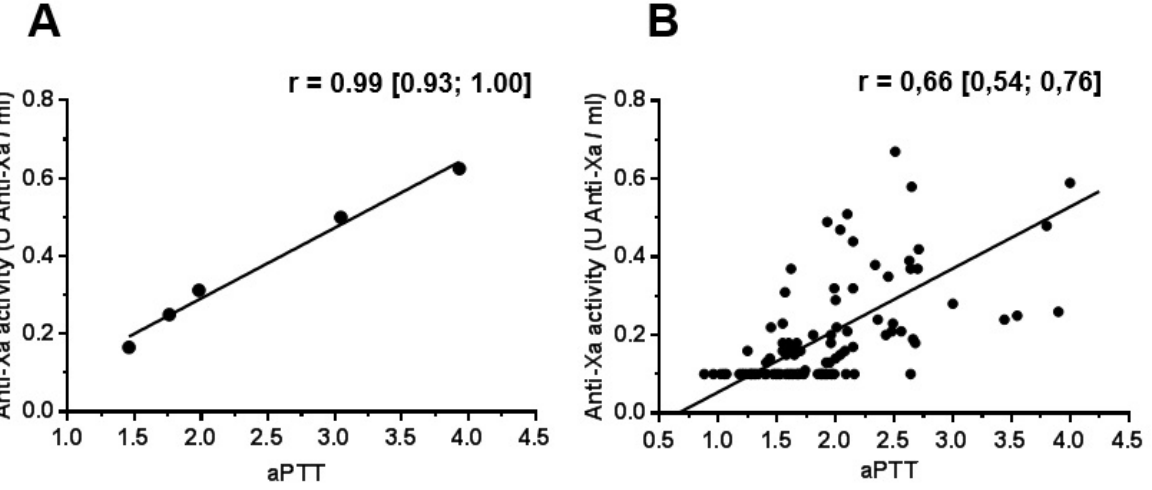
Figure 1. Correlation between aPTT and anti-Xa activity in a spiked normal plasma pool (A) and in ICU patients (B) . Data are presented as Pearson coefficient with 95% confidence interval. aPTT: activated partial thromboplastin time.